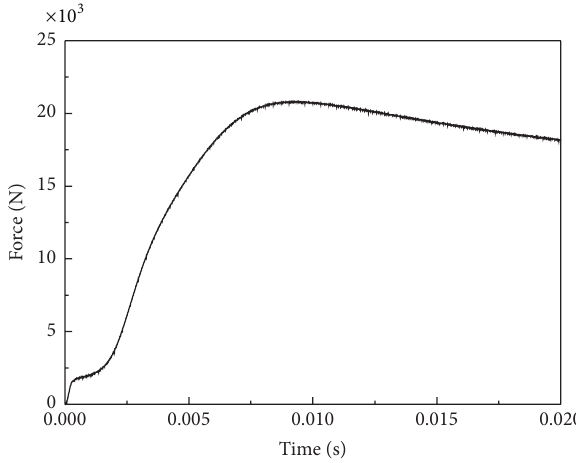
Figure 6: Actuator force without volume